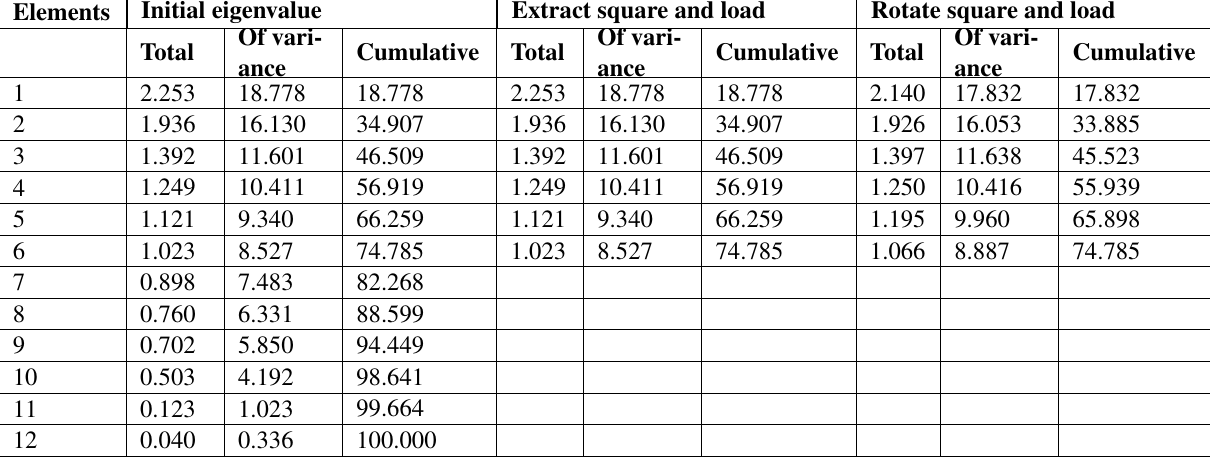
Table 4 Explicatory analysis of total